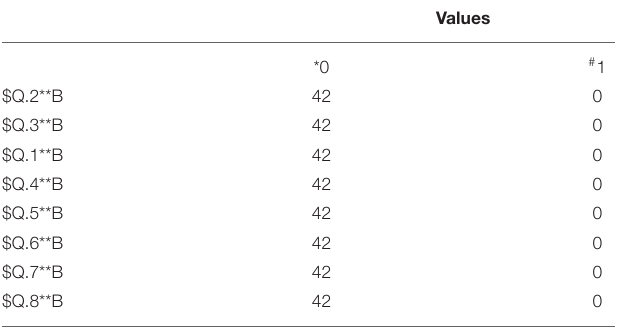
TABLE 4 | Cochran model for global improvement of difficulties after virtual